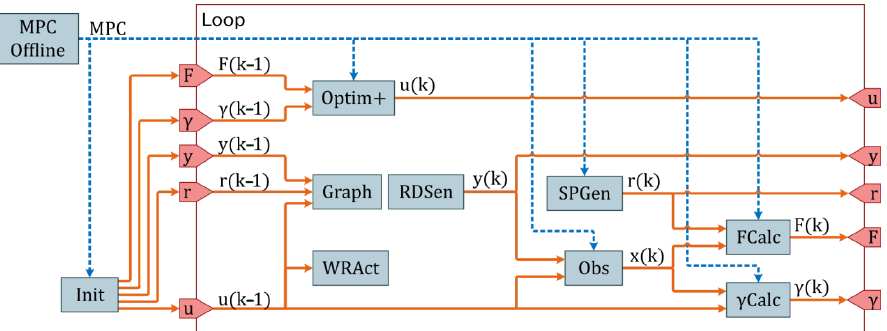
Figure 7. Proposed process flow diagram of the MPC algorithm.